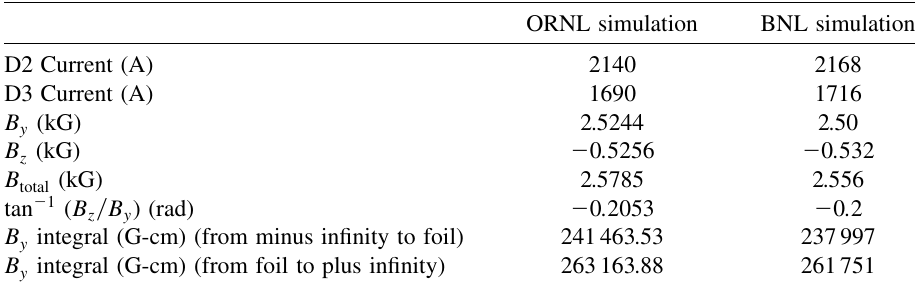
TABLE I. Field distribution around stripping foil from